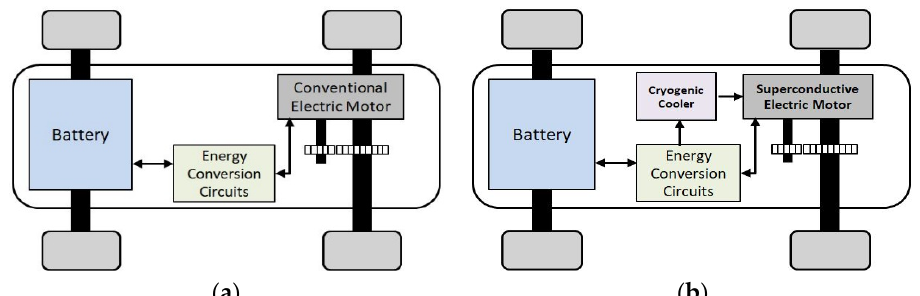
Figure 3. A comparison between a conventional electric vehicle and a vehicle using a superconduc ‐ tive electric motor. ( a ) Block diagram for conventional electric vehicles; ( b ) Possible topology for superconductive motor electric vehicles.